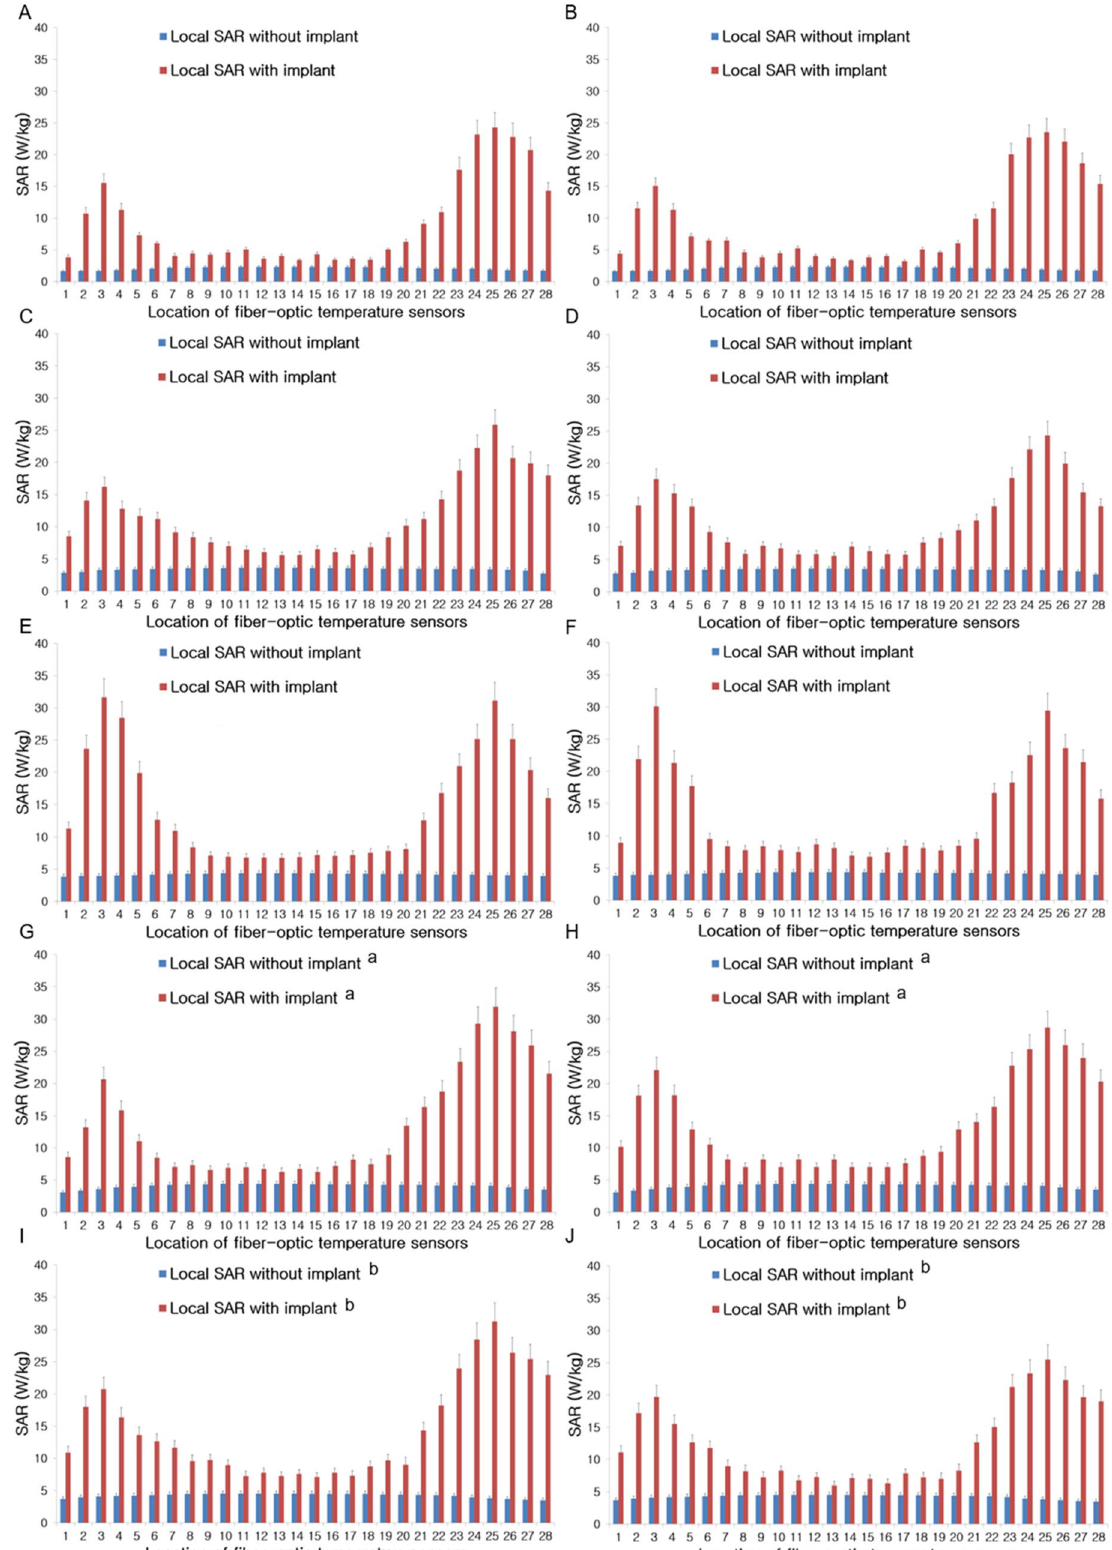
Figure 2. Local SAR levels with and without the implant on the left ( A ) and right ( B ) sides of the metallic hip joints at 1.5 T Philips with T1w TSE sequence, left ( C ) and right ( D ) at 1.5 T GE with IR TSE sequence, left ( E ) and right ( F ) at 3 T Siemens with T1 TIRM sequence and left ( G and I ) and right ( H and J ) at 3 T Philips with T1w TSE sequence (a, b = two same model Philips 3 T MRI systems) and imaging parameters as described in Supplementary Table 1. High SAR values occurred near the head and tail regions of the hip joint implants as compared with the local SAR without the